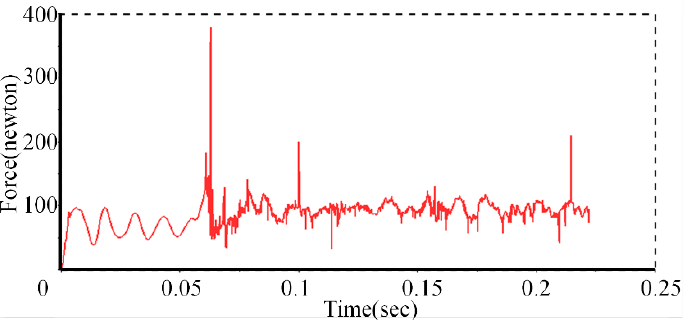
Figure 12. Force between the cross-universal joint active shaft fork and driven shaft fork.